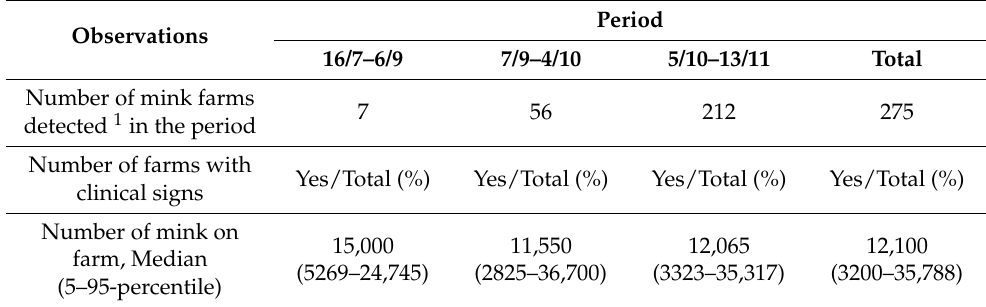
Figure 2. Days from when first clinical signs of SARS-CoV-2 in mink were observed to the observed peak of infection (left) or to when the last clinical signs (right) were observed by the farmer. The thick line illustrates the median, 50% of the observations are within the box, whiskers illustrates the largest value no further than 1.5 inter-quartile range from the box, and dots beyond the whiskers illustrate outliers. The small dots (jitters) within the box and whiskers indicate the observations (one for each farm). Table 3. Clinical signs and mortality observed by farmers in 215 2 Danish mink farms tested positive for SARS-CoV-2 in different periods of the